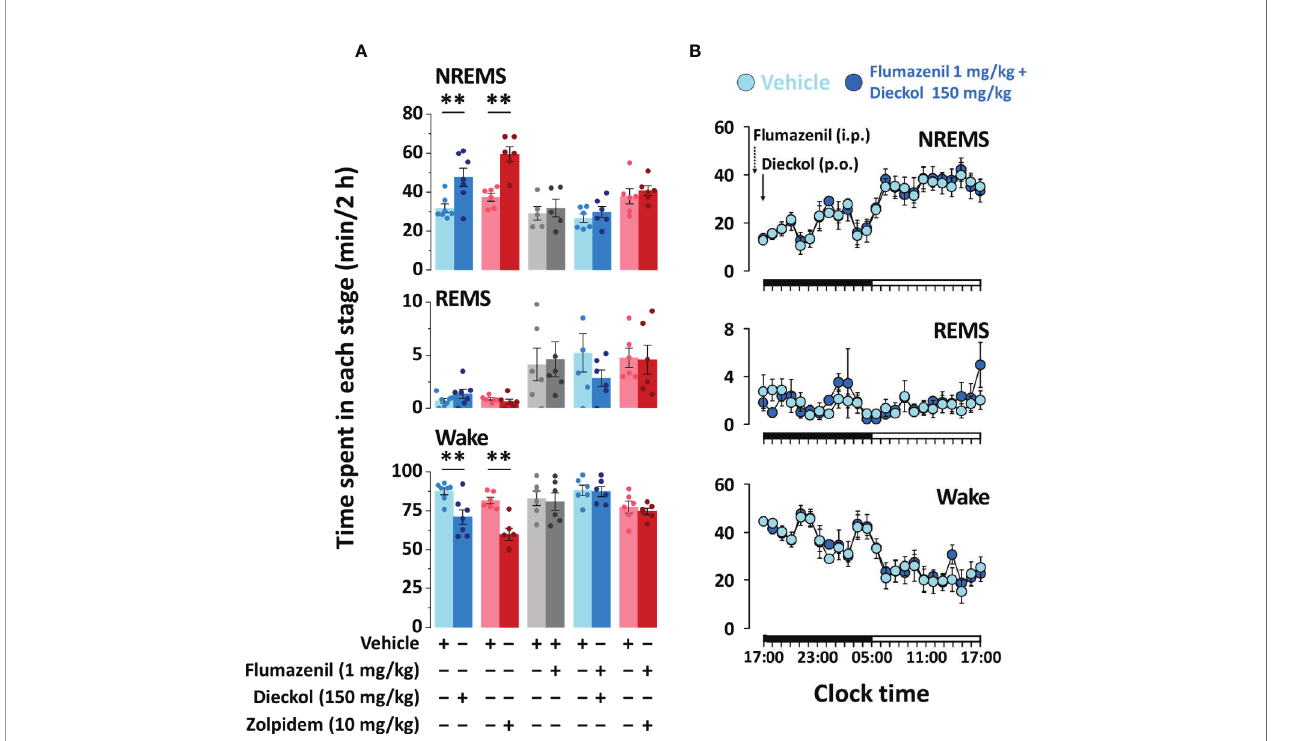
FIGURE 7 | Effect of fl umazenil treatment on dieckol- and zolpidem-induced sleep in C57BL/6N mice. (A) Amount of NREMS, REMS, and Wake for 2 h after pretreatment with fl umazenil (1 mg/kg, i.p. at 16:45 h) and oral administration of dieckol (150 mg/kg, at 17:00 h) or zolpidem (10 mg/kg, at 17:00 h) and each vehicle in mice. Each column represents the mean ± SEM (n = 6-7) with data points. **p < 0.01, signi fi cant difference compared to the vehicle (paired Student ’ s t-test). (B) Time-course changes in NREMS, REMS, and Wake after administration of vehicle, fl umazenil, and dieckol. The horizontal fi lled and open bars on the X-axis (time) indicate the 12 h dark and 12 h light periods,